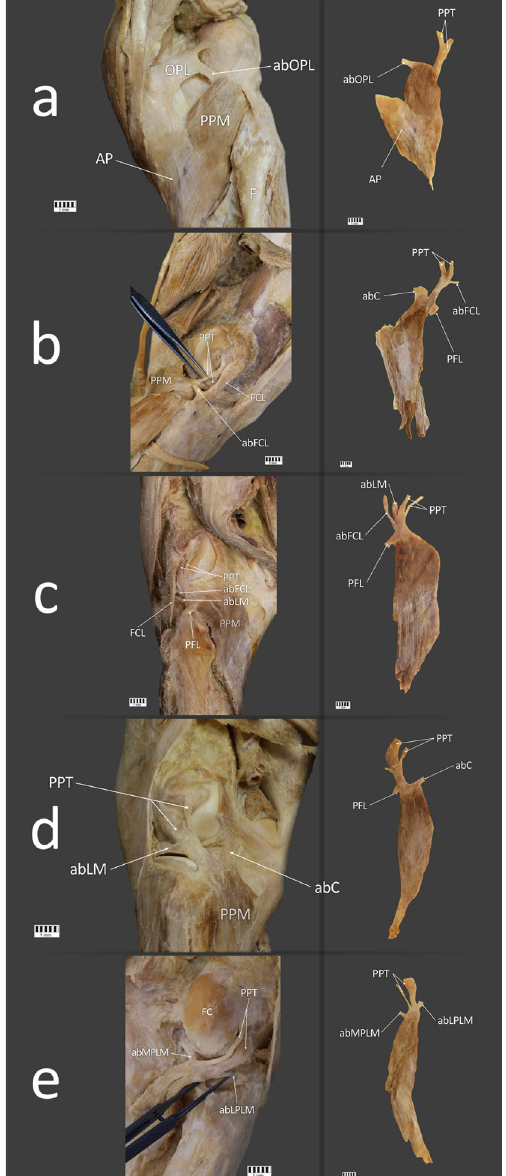
Figure 4. Type IV of the popliteus tendon attachment. ( a ) LEFT—Posterior view of the right knee joint with Type IVa of the popliteus tendon. RIGHT—Isolated popliteus muscle with Type IVa of the popliteus tendon. ( b ) LEFT—Posterior view of the right knee joint with Type IVb of the popliteus tendon. RIGHT—Isolated popliteus muscle with Type IVb of the popliteus tendon. ( c ) LEFT—Posterior view of the left knee joint with Type IVc of the popliteus tendon. RIGHT—Isolated popliteus muscle with Type IVc of the popliteus tendon. ( d ) LEFT— Posterior view of the left knee joint with Type IVd of the popliteus tendon. RIGHT—Isolated popliteus muscle with Type IVd of the popliteus tendon. ( e ) LEFT—Posterior view of the right knee joint with Type IVe of the popliteus tendon. RIGHT—Isolated popliteus muscle with Type IVe of the popliteus tendon. F—fibula, PFL— popliteo-fibular ligament, PPT—popliteus tendon, PPM—popliteus muscle, OPL—oblique popliteal ligament, abOPL—accessory band to the oblique popliteal ligament, FC—femoral condyle, FCL—fibular collateral ligament, abFCL—accessory band to the fibular collateral ligament, abLM—accessory band to the lateral meniscus, abC—accessory band to the knee joint capsule, AP—aponeurosis, abMPLM—accessory band to the medial part of the lateral meniscus, abLPLM—accessory band to the lateral part of the lateral meniscus. The Fig. 4 was taken with Canon EOS 6D camera with Canon EF 100 mm f/2.8 L Macro Is USM, and the signatures were made in Corel DRAW 12 (https:// www. corel draw. com/ pl/ pages/ corel draw-